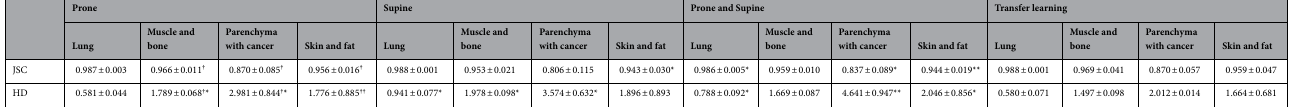
Table 2. The JSC, and HD results of prone, supine, pooled data, and transfer learning from prone to supine in 2D U-Net, respectively. Wilcoxon tests were performed results between prone and supine † , as well as among transfer learning vs prone, supine, and prone to supine*, respectively; † , *, p -value < 0.05; †† , **, p -value < 0.001; JSC, Jaccard similarity coefficient; HD, Hausdorff